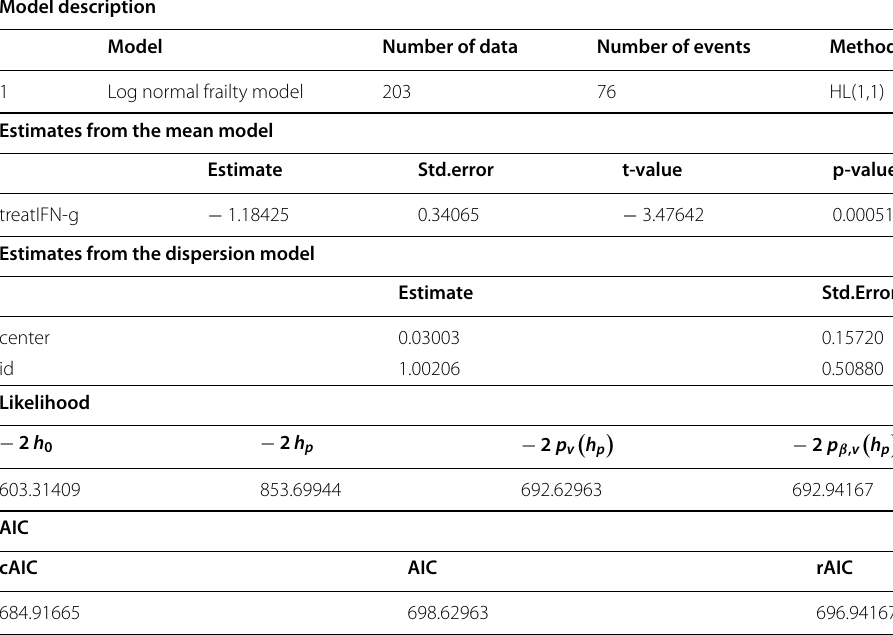
Table 8 Model description for log normal frailty Model